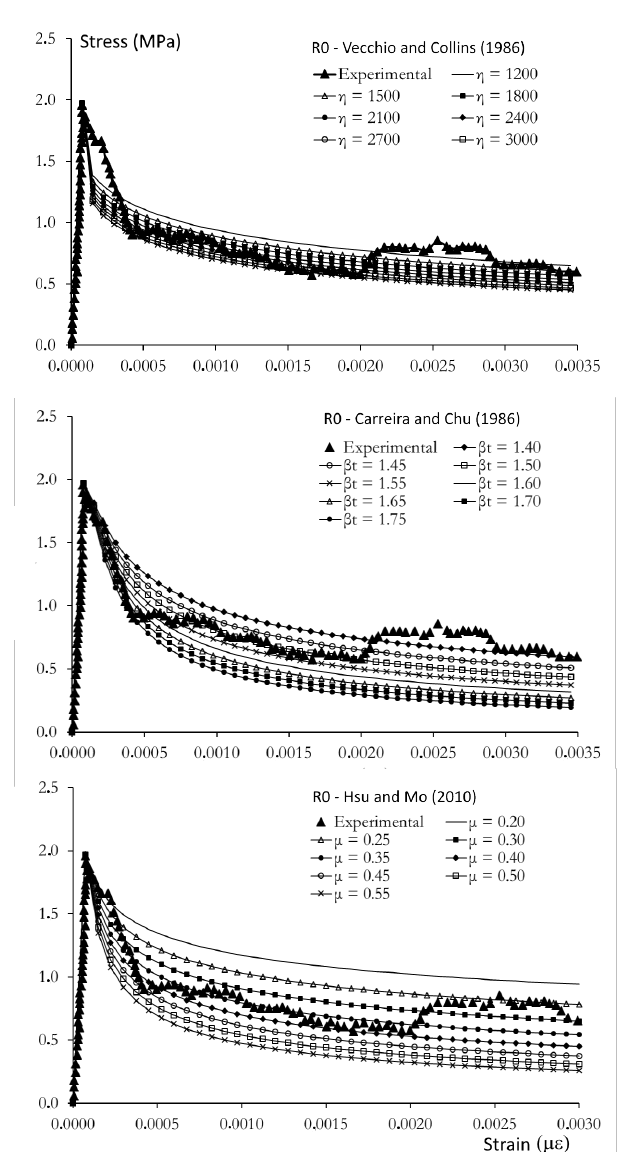
Figure 8. Parametric study of analytical models for the R0 tension stiffening